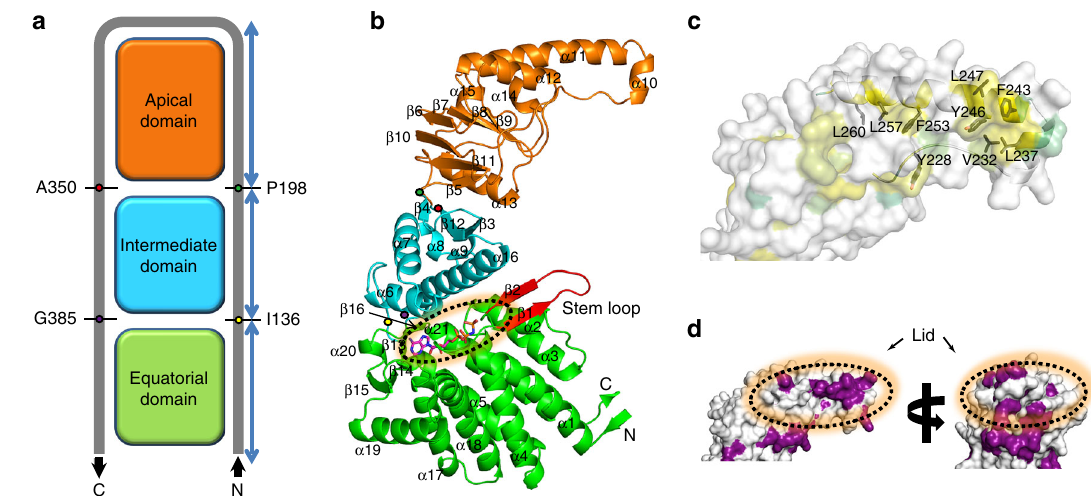
Fig. 1 Subunit structure of Ch-CPN. Equatorial, intermediate, and apical domain are colored in green, cyan, and orange, respectively. The N- and C-termini are labeled as N and C, respectively. a Schematic representation of C α tracing of Ch-CPN subunit. Four key residues connecting the domains are labeled. b Ribbon diagram of Ch-CPN subunit. The nucleotide-binding site and stem loop are indicated by a dotted circle and red ribbon, respectively. The key residues (I136, P198, A350, and G385) are marked by yellow, green, red, and purple circles, respectively. α -Helices and β -strands are numbered consecutively from the N-terminus to the C ‐ terminus. c Hydrophobic surface of the apical domain. The surfaces are colored based on the hydrophobicity of the side chains (from yellow for most hydrophobic, to lime for decreasing hydrophobicity). The crowded hydrophobic residues on the lid are labeled and presented as black sticks. d Residue conservation in the apical domain. Highly conserved residues are colored in purple. Amino acid sequences of the Group III CPNs which is used for residue conservation are described in Supplementary Fig. 2. The lid is indicated by